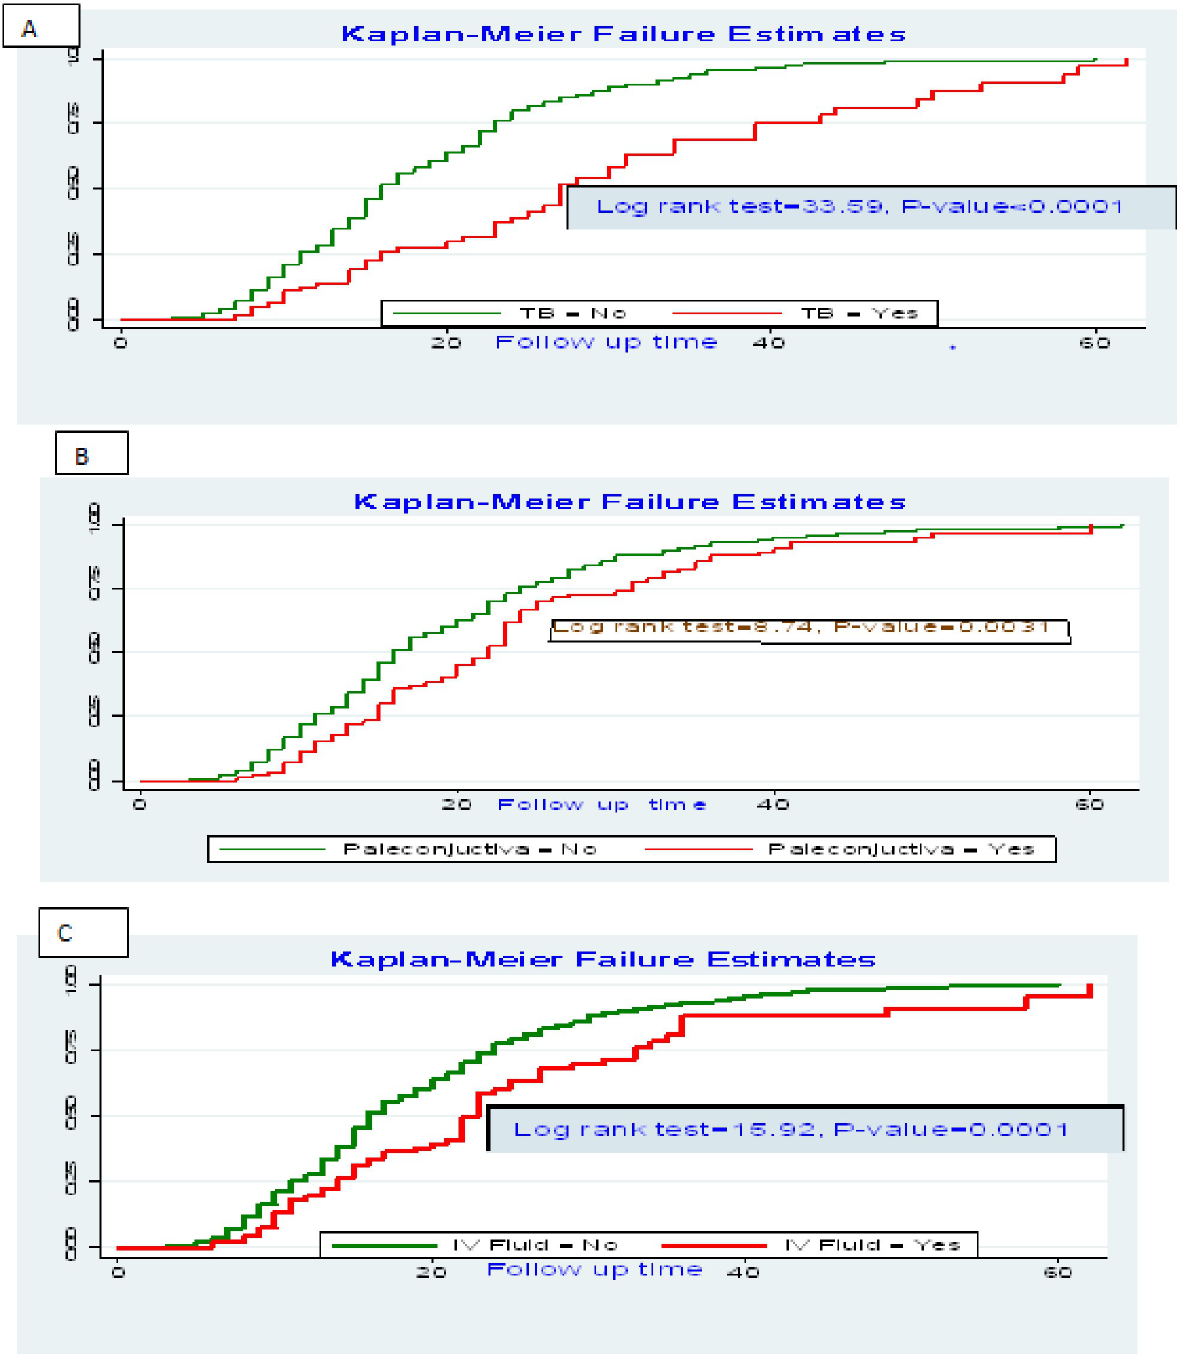
Fig 4. Log rank survival estimates for time to recovery among SAM children with independent predictors in SPHMMC, Addis Ababa, Ethiopia form 2012 to 2019 (A: Survival estimate with TB; B: Survival Estimate with pale conjunctivitis; C: Survival Estimate with IV fluid infusion).